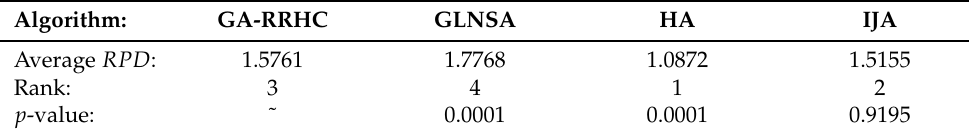
Table 8. Algorithm ranking and Friedman test value for Rdata